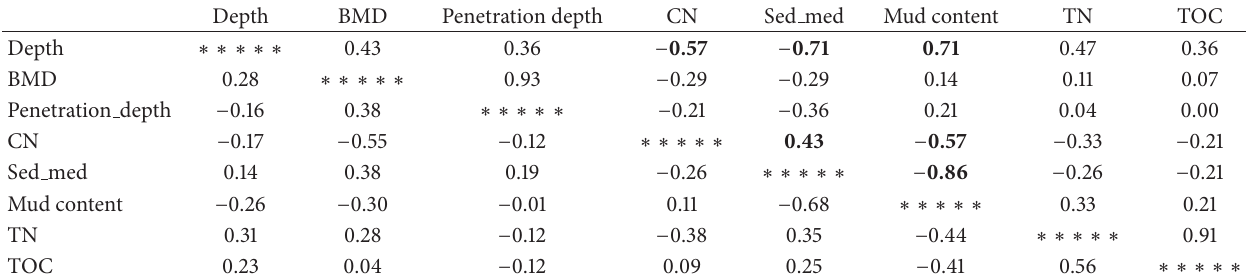
Table 7: Kendall’s rank correlations between selected important environmental variables, calculated separately for subsets of sites near the positive (Subset+; 𝑛 = 8 ; upper triangle) and negative ends (Subset − ; 𝑛 = 22 ; lower triangle) of the main coenocline (DCA1). Sites 4 and 6 are included in both subsets. Correlation coefficients between variables strongly correlated with depth in Subset+ are shown in bold. See Table 2 for description of environmental